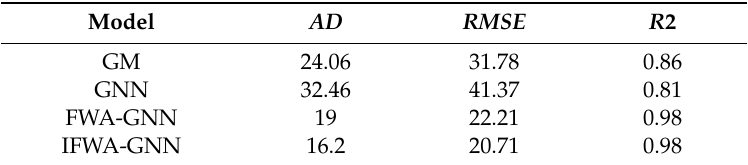
Table 11. The evaluation